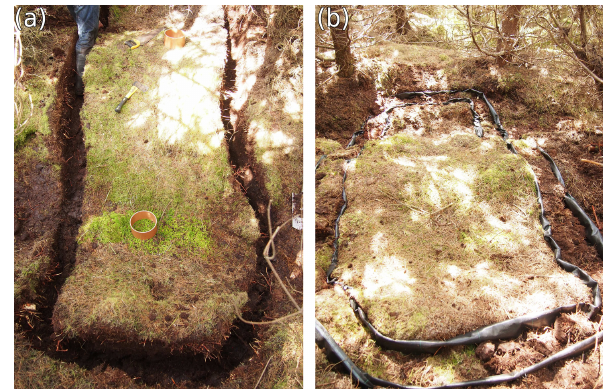
Figure 2. (a) Trenching plot dug and all living tree roots are sawn trough. (b) Finished trench plot; trenches double lined with polypropylene gardening cloth and filled in with